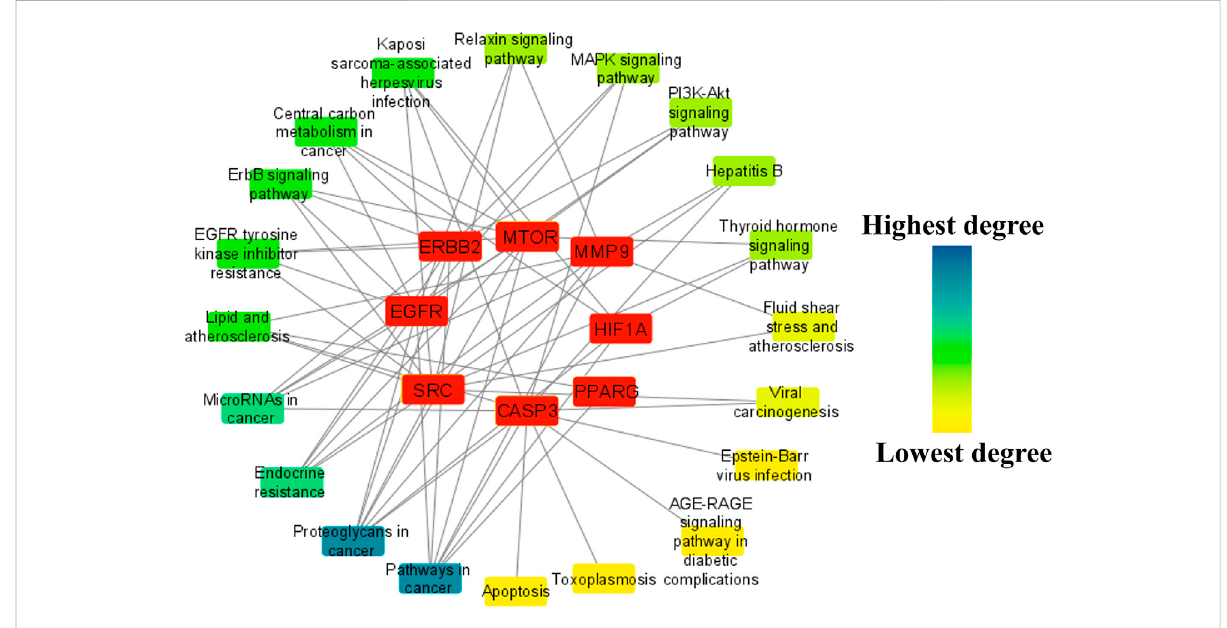
FIGURE 9 The network between the top eight anti-HCC core targets and their corresponding molecular pathways.